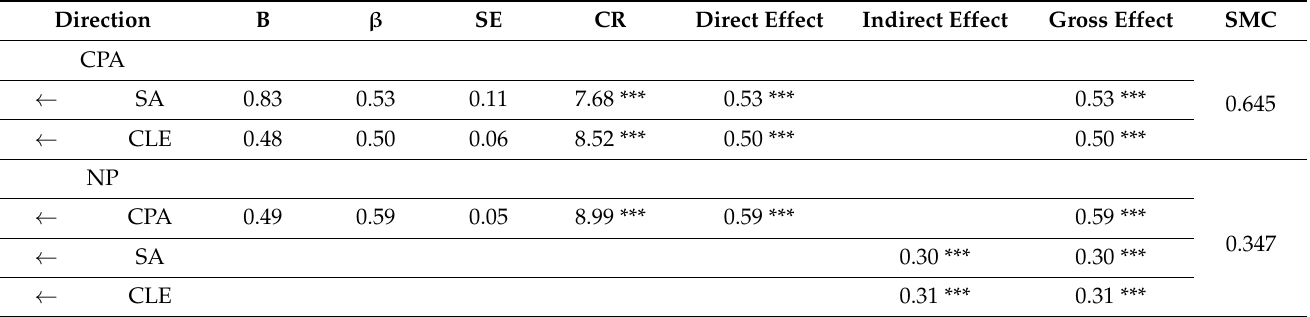
Table 6. Path analysis between variables of the study